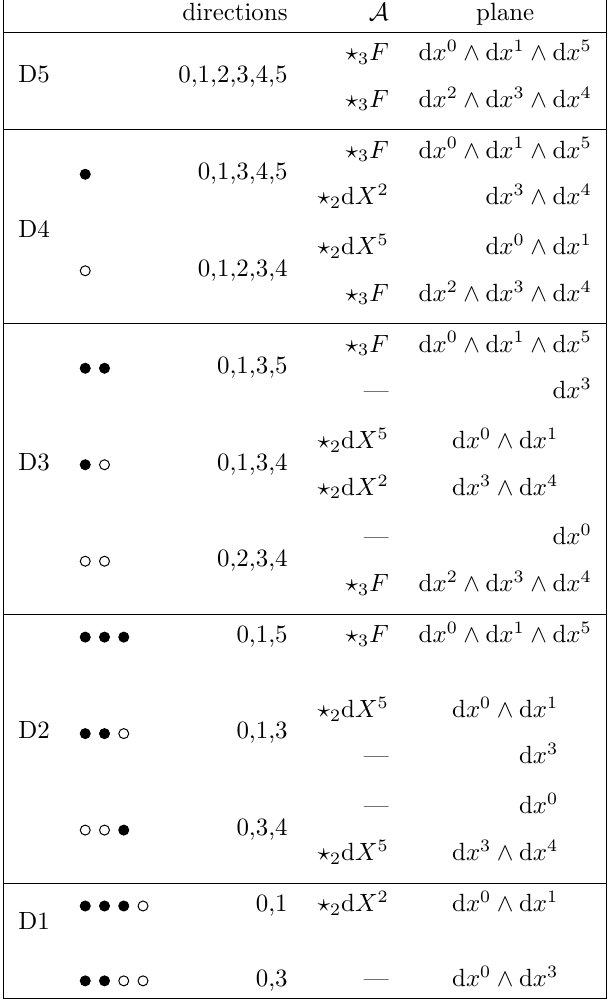
Table 3 . Duality web of brane deformations starting from the D5 brane setup. We give the type of T-duality as in (cid:12)gure 1 in the second column, the form of the deformation connection A in the third column along with the plane in which that A acts in the fourth column (note that we have dropped any signs for